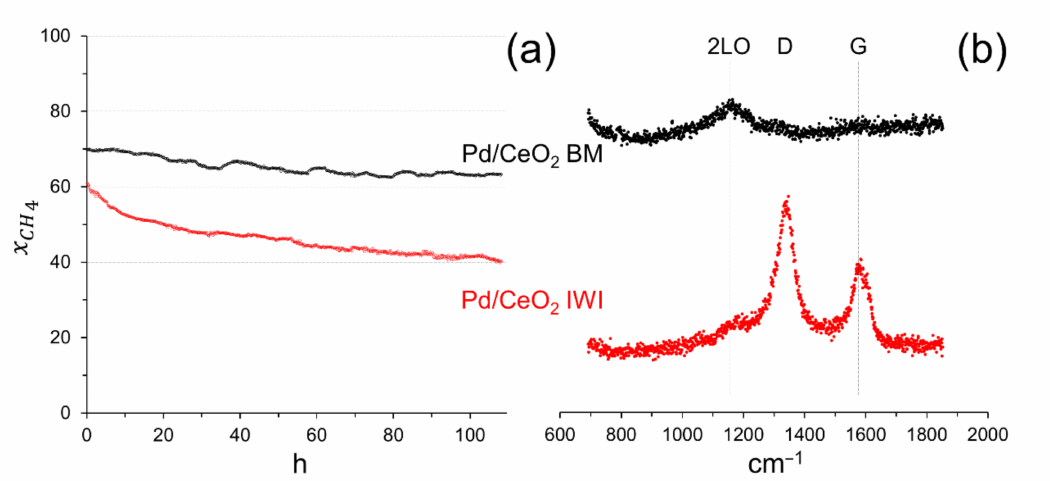
Figure 6. ( a ) Methane conversion in a long-term stability test at 550 ◦ C on Pd/CeO 2 prepared by milling CeO 2 and Pd acetate (5 min at 50 Hz, 0.5 wt.% Pd; Pd/CeO 2 BM) and by incipient wetness impregnation with Pd acetate (Pd/CeO 2 IWI). GHSV = 12 × 10 3 h − 1 , F/W = 60 L h − 1 g − 1 . ( b ) Raman spectra recorded on the samples after